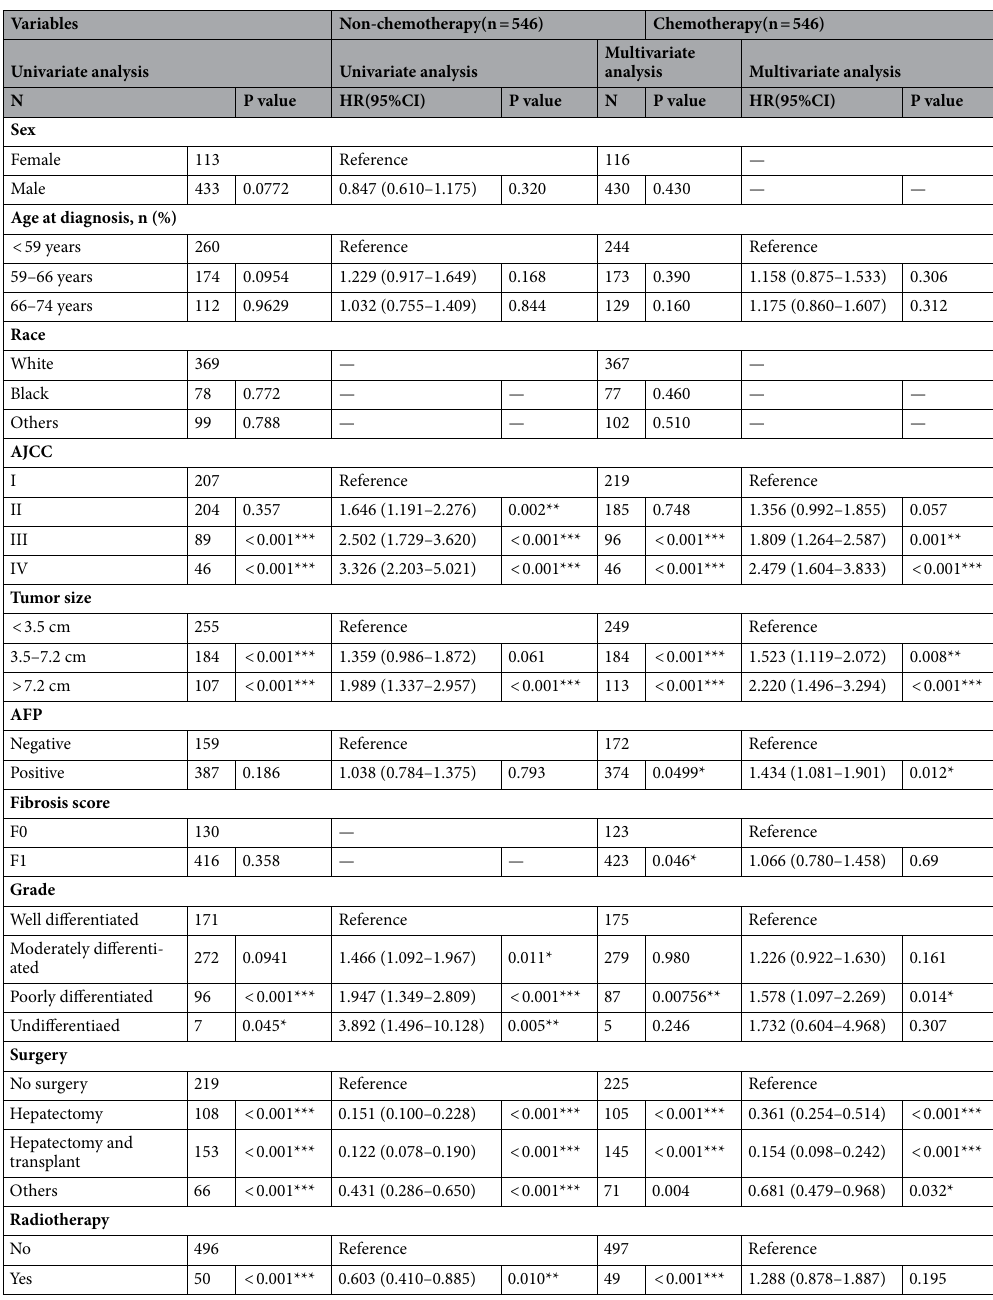
Table 2. Univariate and multivariate analysis of OS in the patients with chemotherapy and without chemotherapy. *Two-sided P values < 0.05. **Two-sided P values < 0.01. ***Two-sided P values < 0.001. OS, overall survival; HR, hazard ratio; CI, coindidence intervals; AJCC, American Joint Committee on Cancer (7th). F0, fibrosis score 0–4, non to moderate fibrosis; F1, fibrosis score 5–6, severe fibrosis and